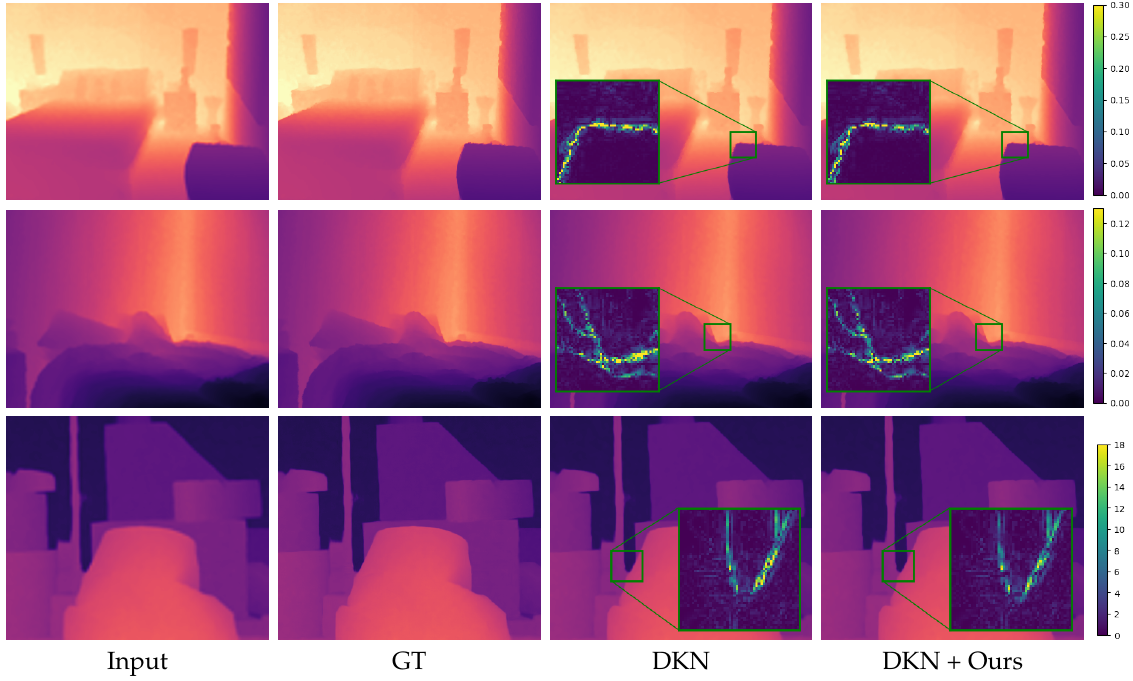
Figure 5. RGB-guided super-resolution results. The input is upscaled for visualization purposes. Insets show absolute difference to ground truth. The first two rows are examples from the NYU v2 [33] test set and the third row from the Middlebury dataset